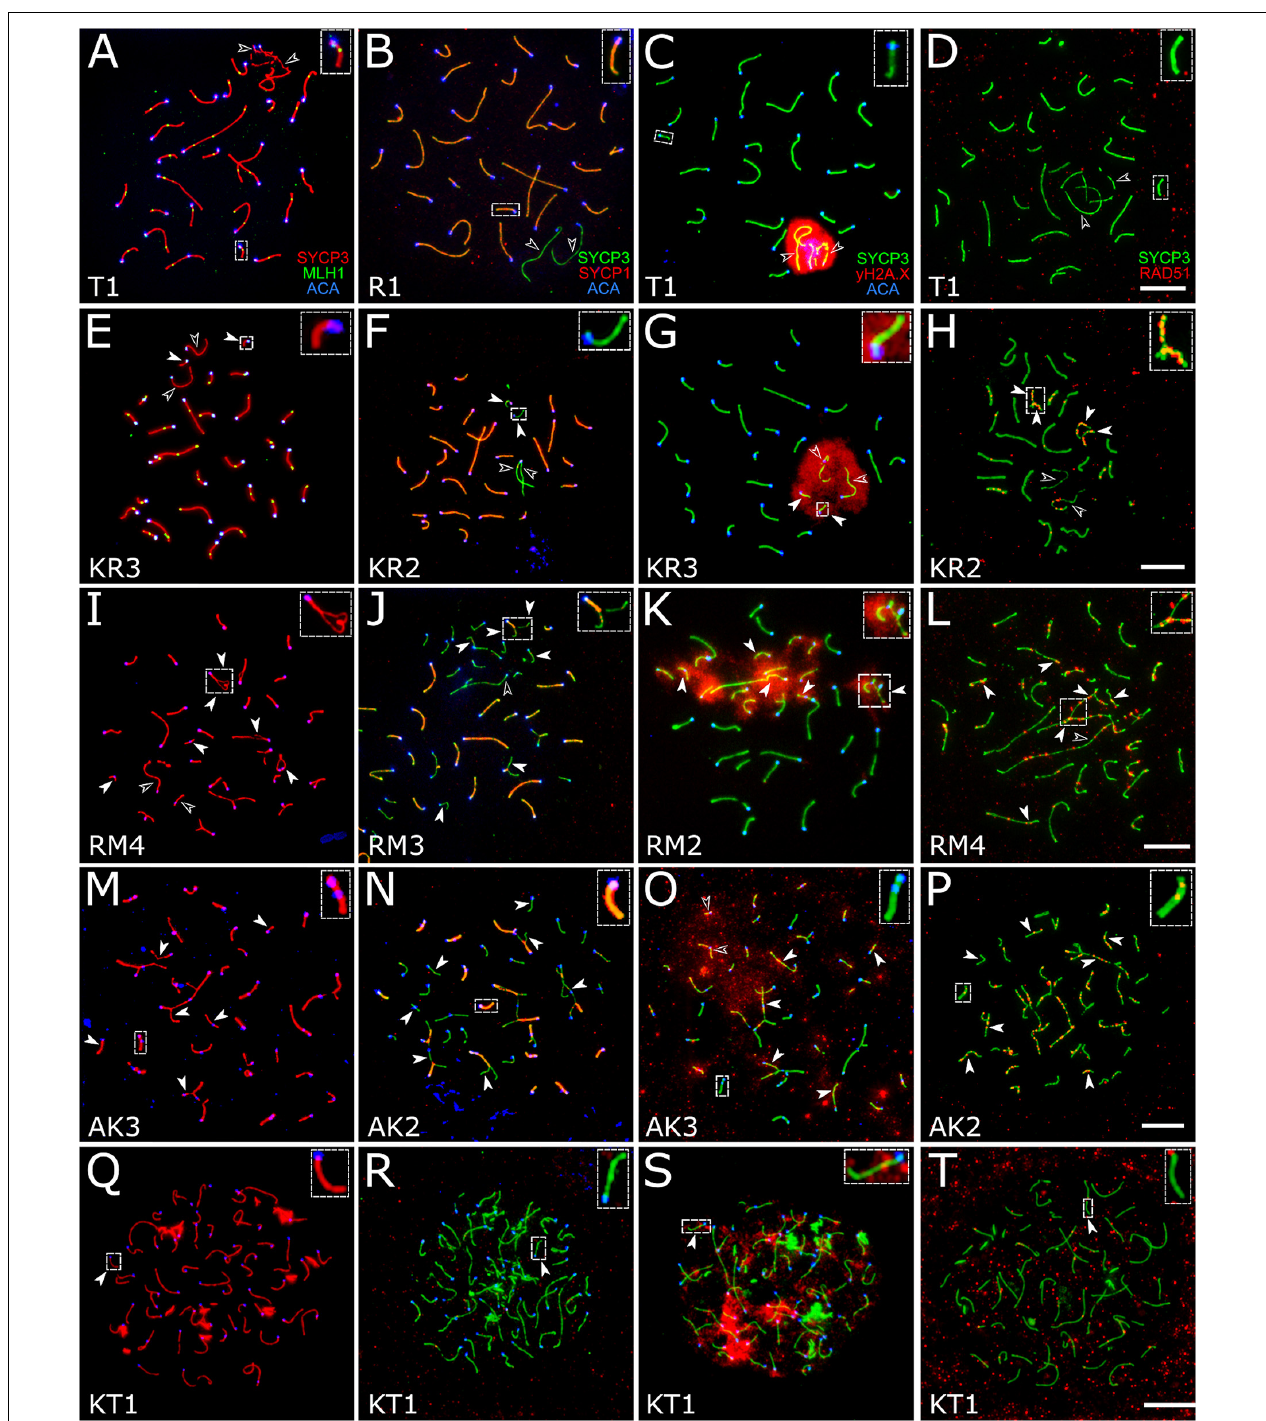
FIGURE 4 | Spermatocytes of interspecies hybrid voles at different stages of prophase I. First row: the pachytene stage in the parental species [ M. transcaspicus (A–D) ]. Second row: the pachytene-like stage in the hybrids between species with the same karyotypes [ M. kermanensis × M. rossiaemeridionalis , (E–H) ]. Third row: the zygotene-like stage in the hybrids between species with the same karyotypes [ M. rossiaemeridionalis × M. kermanensis , (I–L) ]. Fourth row: the zygotene-like stage in the hybrids between species with different karyotypes [ M. arvalis × M. kermanensis , (M–P) ]. Fifth row: the leptotene-like stage in the hybrids between species with different karyotypes [ M. kermanensis × M. transcaspicus , (Q–T) ]. Columns show immunolocalization of the meiotic proteins: MLH1, SYCP1, γ H2A.X, and RAD51, respectively. Arrowheads point to univalents or asynapsed chromosome regions; arrowhead outlines show distinguishable sex chromosomes. Letters and numbers in the bottom left corner of each image represent the type of cross and individual specimen number. Bar: 10 µ m.